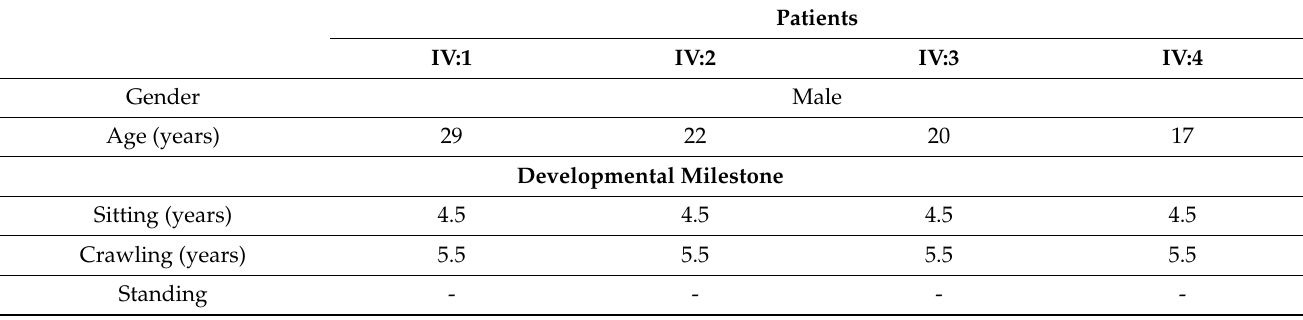
Table 1. Summary of clinical features of the patients in this